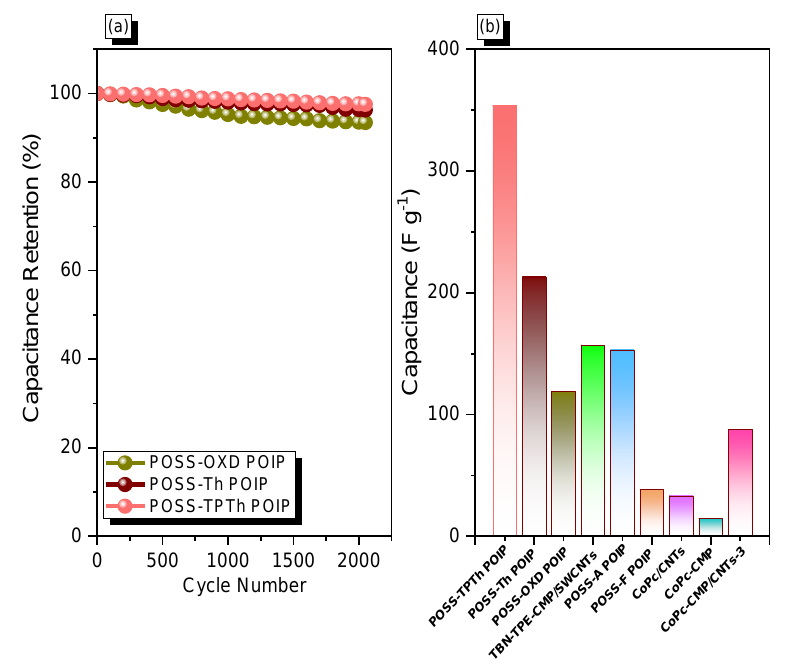
Figure 9. ( a ) Durability and ( b ) electrochemical performance of the POSS-OXD, POSS-Th, and POSS-TPTh POIPs, compared with those of previously reported porous materials. Additionally, we investigated the electrochemical characteristics of all three POSS- POIP samples in two electrode systems for a symmetric supercapacitor through coin